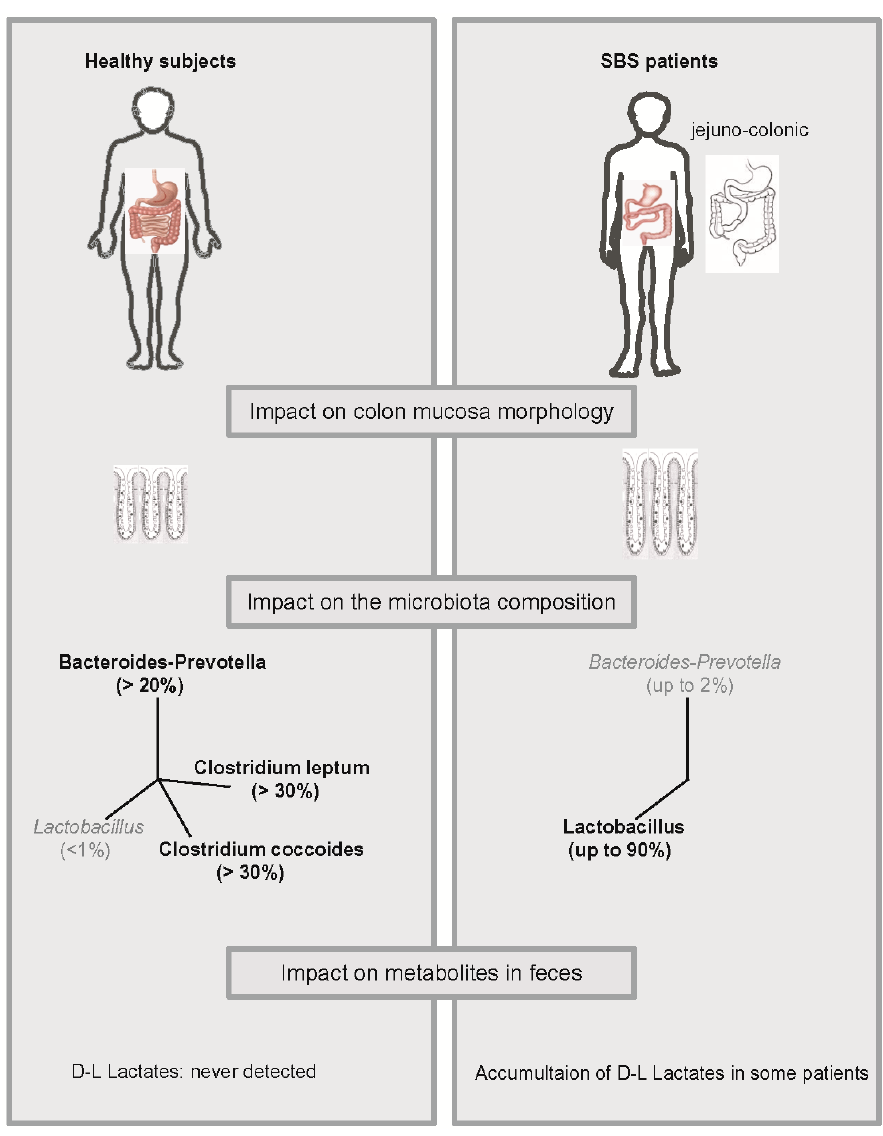
Figure 1. Intestinal resection induces a modification in colon mucosa morphology, microbiota composition, and lactate accumulation in feces.